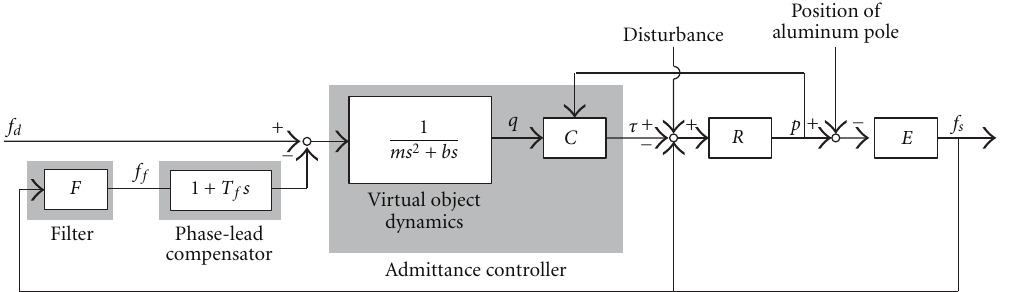
Figure 14: Block diagram of an admittance-controlled system ( F : filter, s : di ff erentiator, T f : constant, C : position controller, R : manipulator dynamics, E : environmental dynamics).